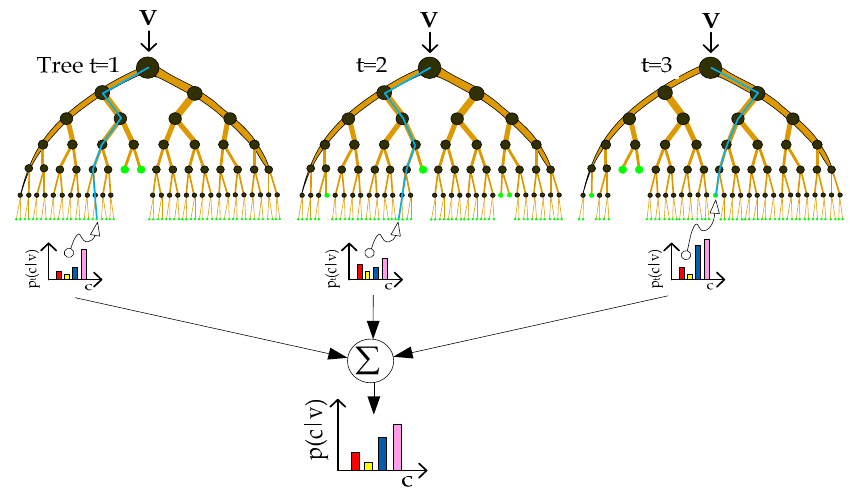
Figure 3. Classification process of RF (adapted from [49]).